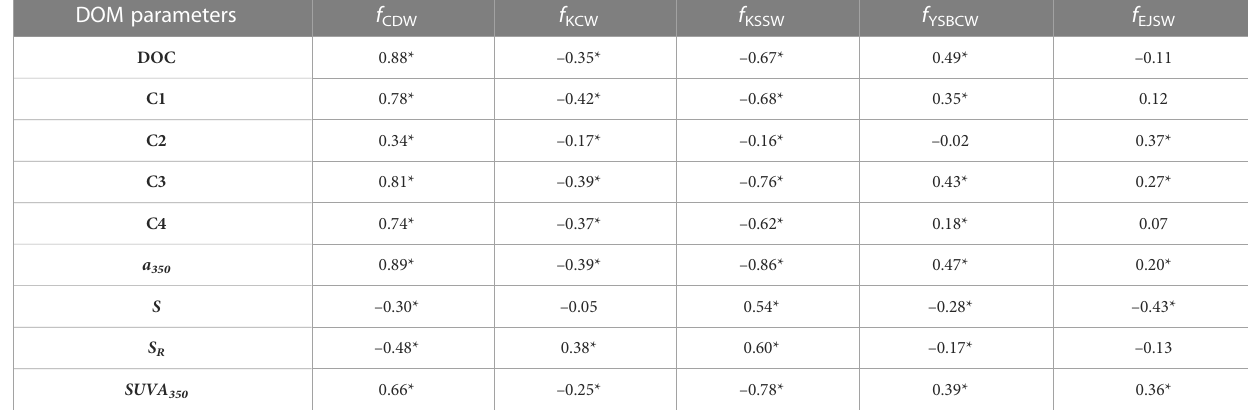
TABLE 2 The correlation coef fi cient values of the water mass fraction ( f ) of different water masses versus DOM parameters (* indicates p < 0.05). DOM